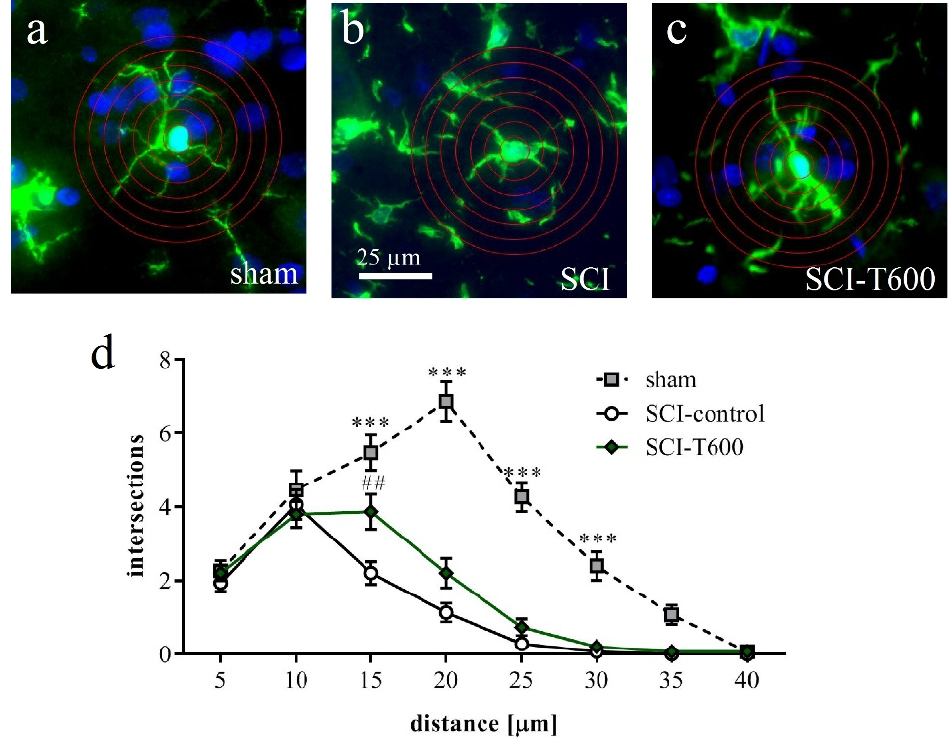
Figure 10. Effect of SCI and TUDCA treatment on microglia morphology. ( a – c ) Examples of Iba-1 IR cells in the spinal cord gray matter at 8 mm distance from the injury site at 4 days after sham operation ( a ), SCI control ( b ) and SCI with TUDCA treatment ( c ) are shown with superimposed rings for Sholl analysis. ( d ) Number of intersections of cellular processes at 5 µ m intervals from the cell soma [two-factor ANOVA, distance from soma F (7, 335) = 78.6, p < 0.0001; treatment effect: F (2, 335) = 107, p < 0.001; interaction: F (14, 335) = 12.9, p < 0.001, results of Bonferroni multiple comparison tests are indicated with *** ( p < 0.001) for sham vs. SCI-control and sham vs. SCI-T600 and with ## ( p < 0.01) for SCI vs. SCI-T600]. All panels have the same magnification (scale bar in b